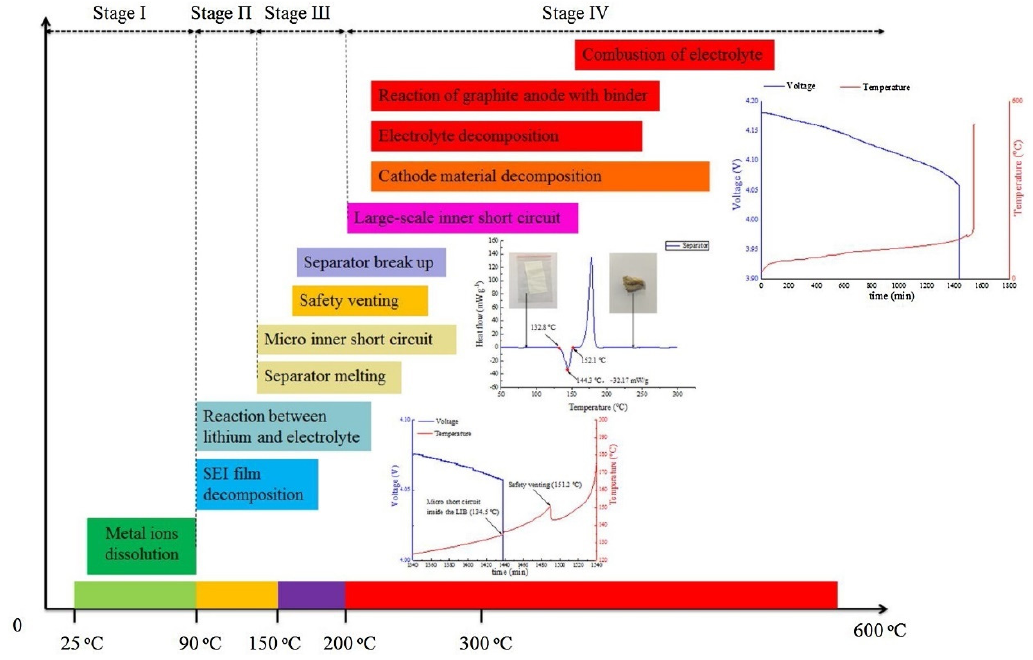
Figure 2. Stages of temperature-induced thermal runaway [26]. Table 1. Effect of SOC on onset temperature of thermal runaway, propagation time in a single cell, and propagation time between cells in pack.